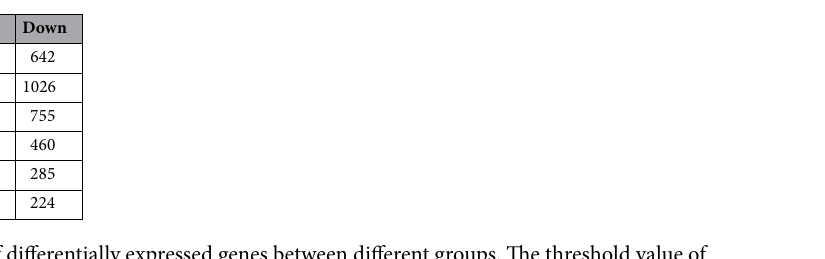
Table 2. Number of differentially expressed genes between different groups. The threshold value of significance was DESeq2 p value ≤ 0.05 |log2FoldChange|≥ 0.0.